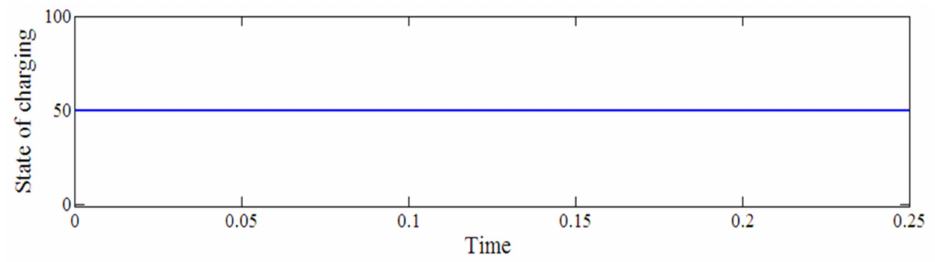
Figure 11. State of Charging (%) of wind-powered